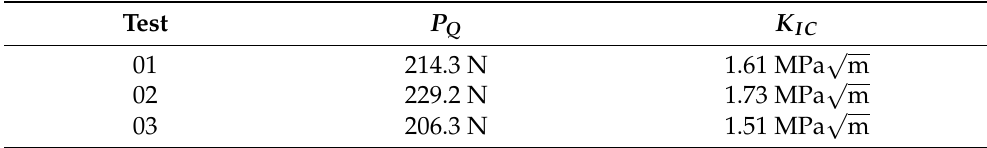
Table 1. Fracture toughness test results.